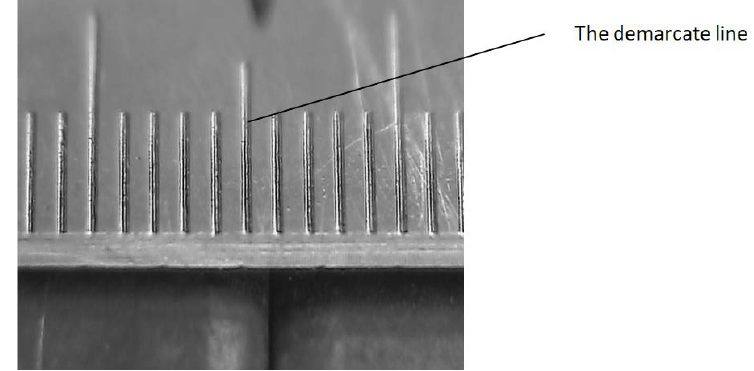
Fig. 2 Demarcate of visual camera